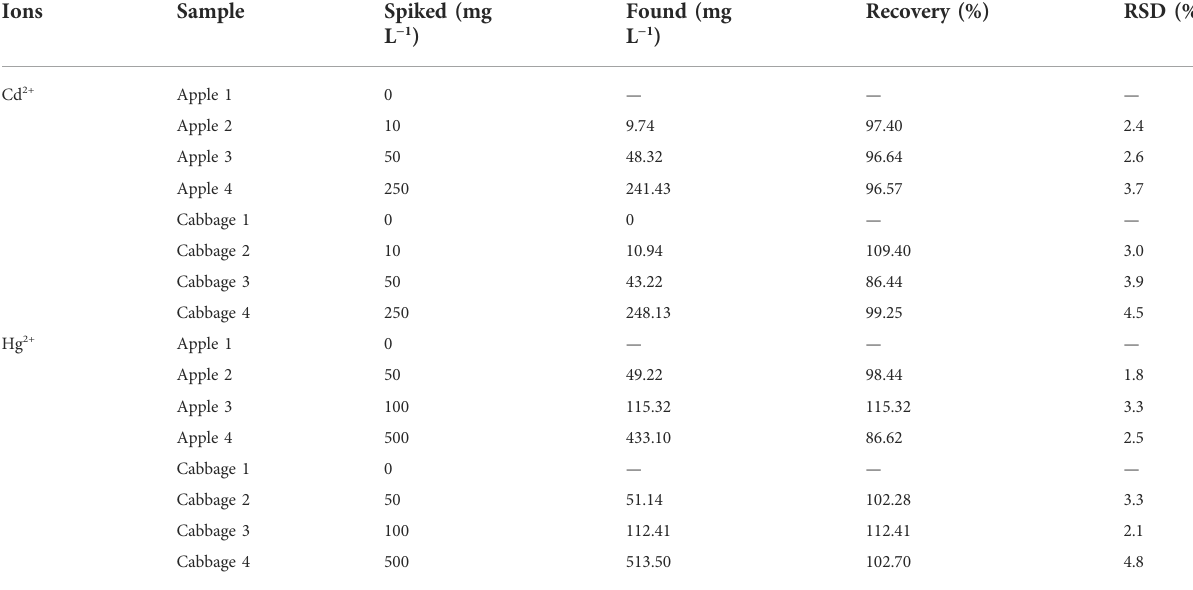
TABLE 3 Analytical results for determination of Cd 2+ and Hg 2+ in real samples.